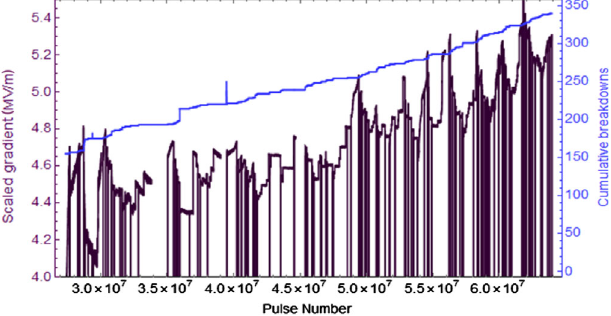
FIG. 20. A section of 400 Hz photoinjector conditioning data showing scaled gradient and cumulative